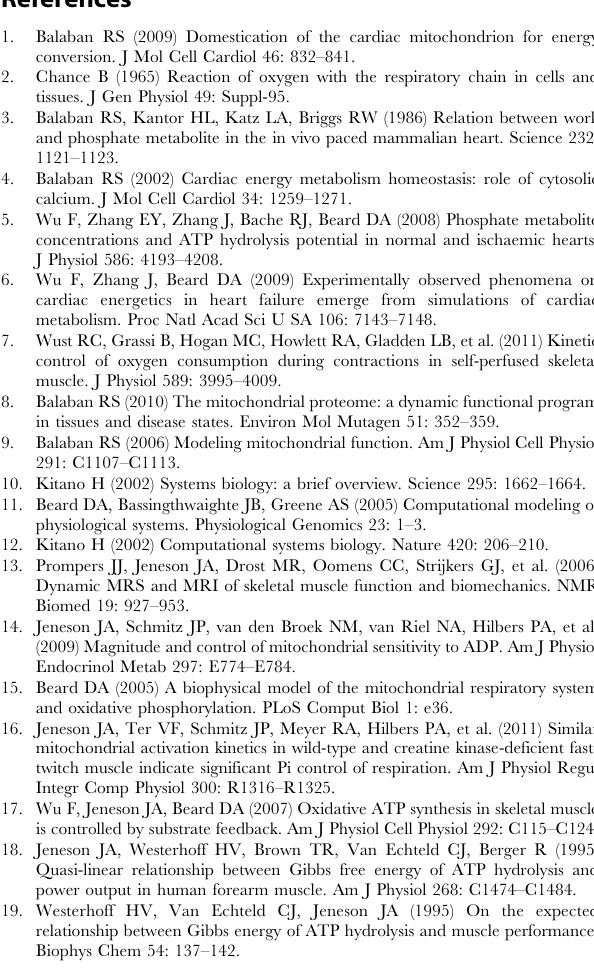
Table S4 Range of parameter values explored in Monte Carlo simulation approach (model configuration i ). Table S5 Range of parameter values explored in Monte Carlo simulation approach (model configuration ii ). Table S6 Parameter settings for the simulations of post exercise recovery dynamics (Figure